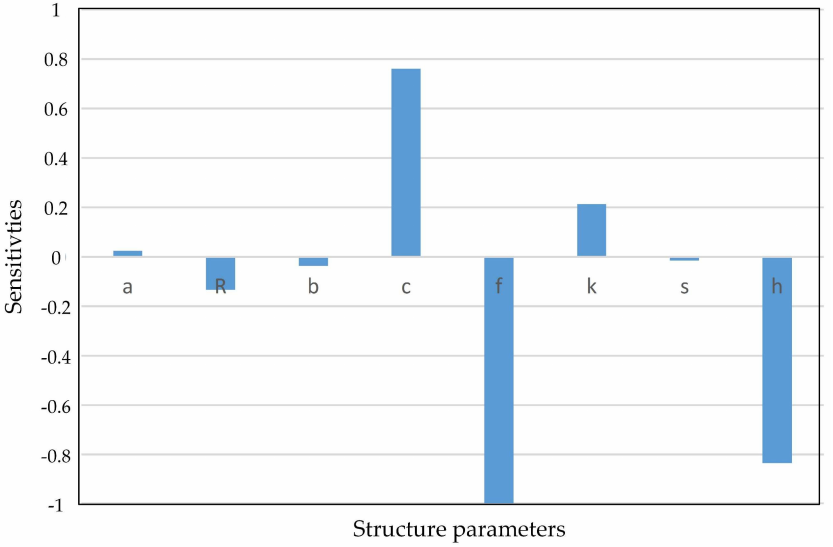
Figure 10. Parameter sensitivity after